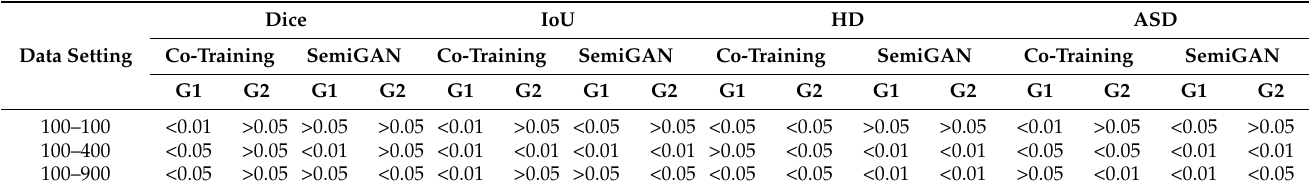
Table 12. Paired t -test between Diff-CoGAN, co-training, and semi-GAN using the Spleen dataset.